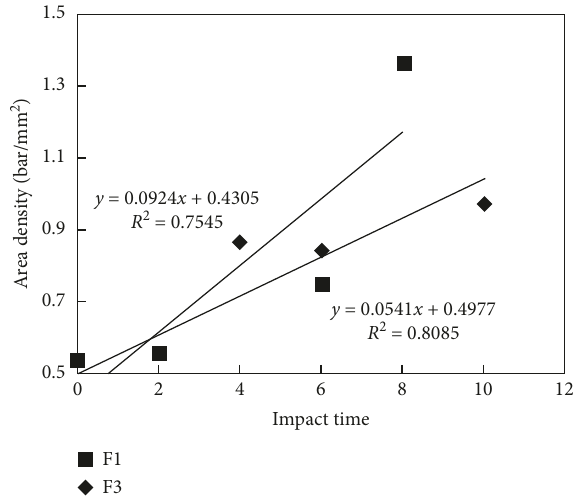
Figure 9: Plots of areal density to shock times for fat coal samples.